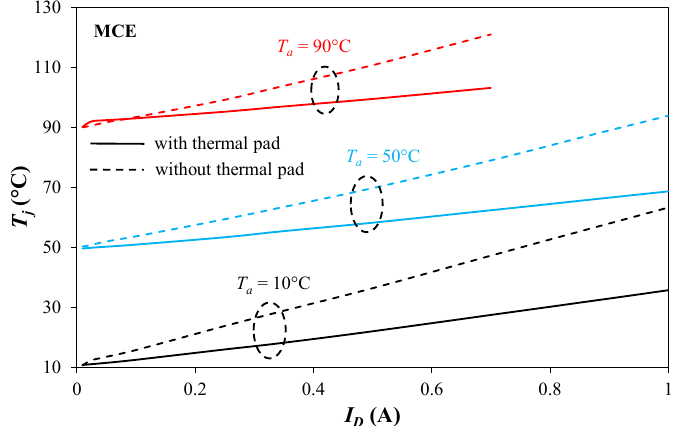
Figure 7. Measured dependences of the junction temperature of the MCE diodes on forward current for different values of the cold plate temperature.